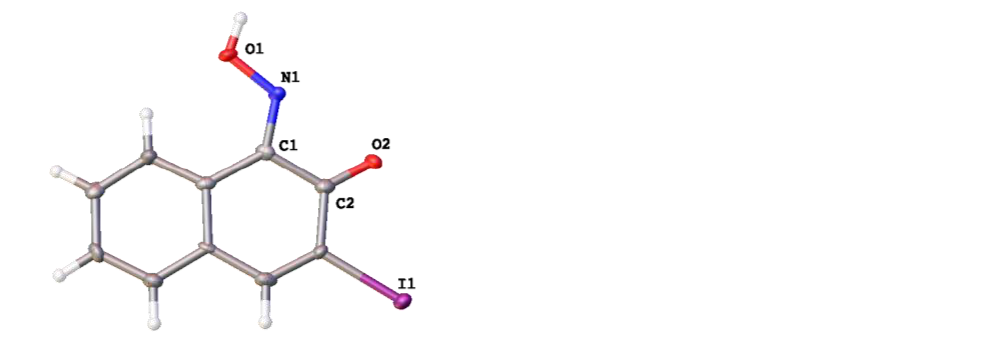
Figure 1. View of the molecular structure of I-NON obtained from XRD study. Nonhydrogen atoms are given as probability ellipsoids of atomic displacements ( p = 0.5).